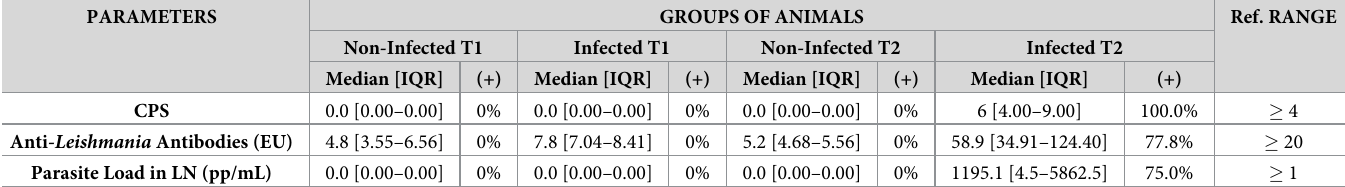
Table 2. Characteristics of the dog population used in the current study at the two points studied.